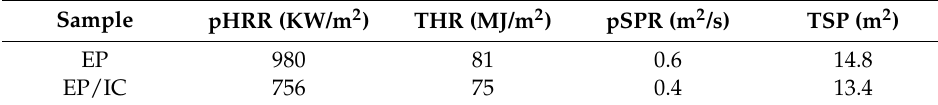
Figure 8. ( a ) HRR vs time, ( b ) THR vs time, ( c ) SPR vs time and ( d ) TSP vs time curves of EP and EP/IC. Table 3. The cone calorimeter test data of EP and Table 3. The cone calorimeter test data of EP and EP/IC .